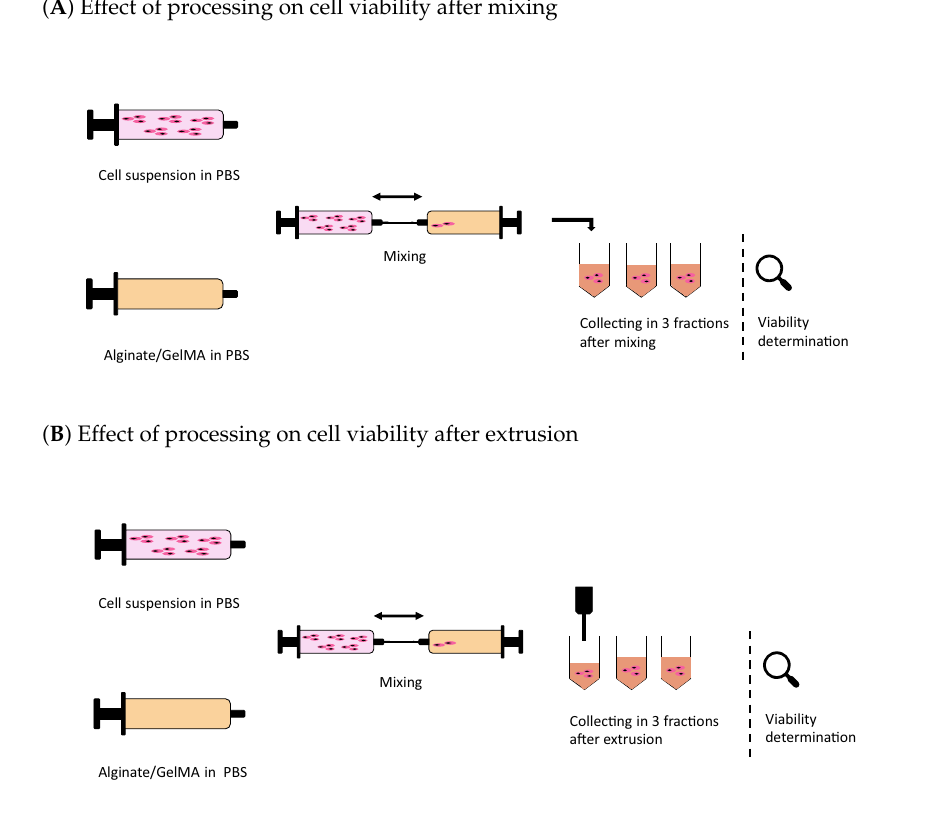
Figure 2. Schematic of the workflow applied for the determination of the processing effects on cell viability. A biological replicate consisted of cells harvested independently and mixed with the biomaterial ink. In ( A ), the processing ended after mixing the cellular material into the biomaterial ink, which was collected in three fractions. In ( B ), the processing of the bioink consisted of mixing it with the cell suspension and extrusion with the printer. The extruded bioink was collected in three fractions. Each collected fractions was diluted separately before cellular staining and data acquisition with a flow cytometer. Three biological replicates of each process were performed; therefore, each biological replicate was completed before starting the next